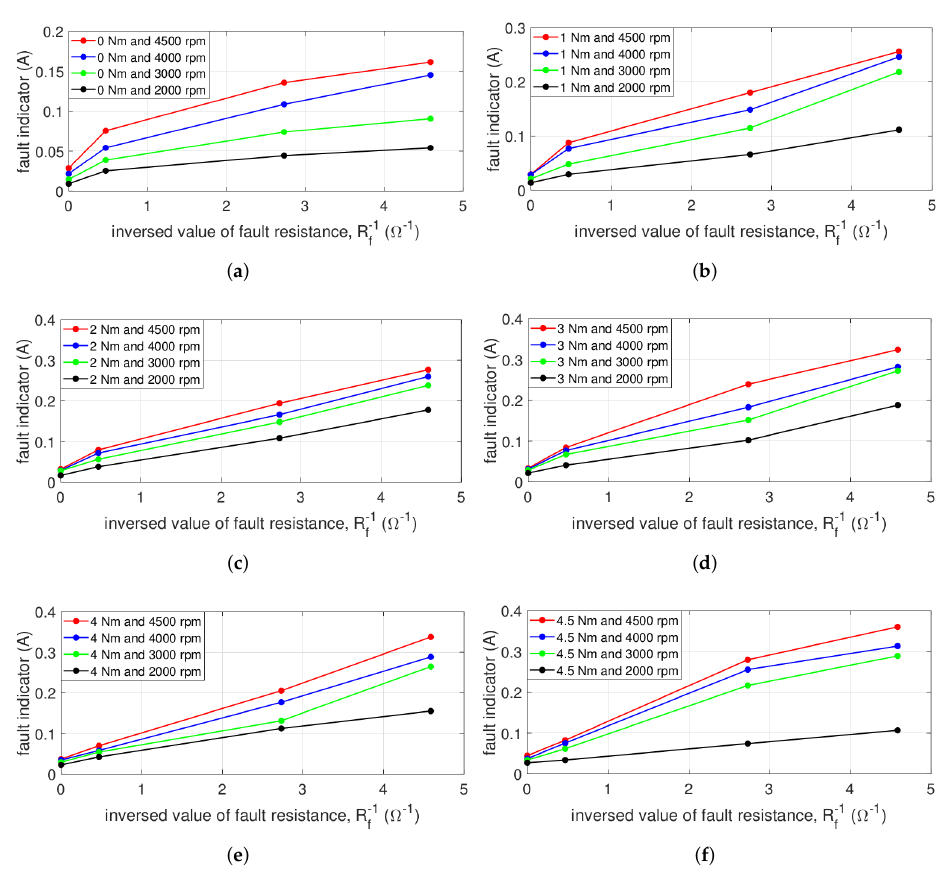
Figure 15. Fault indicator with the inversed value of R f at ( a ) 0, ( b ) 1, ( c ) 2, ( d ) 3, ( e ) 4, and ( f ) 4.5